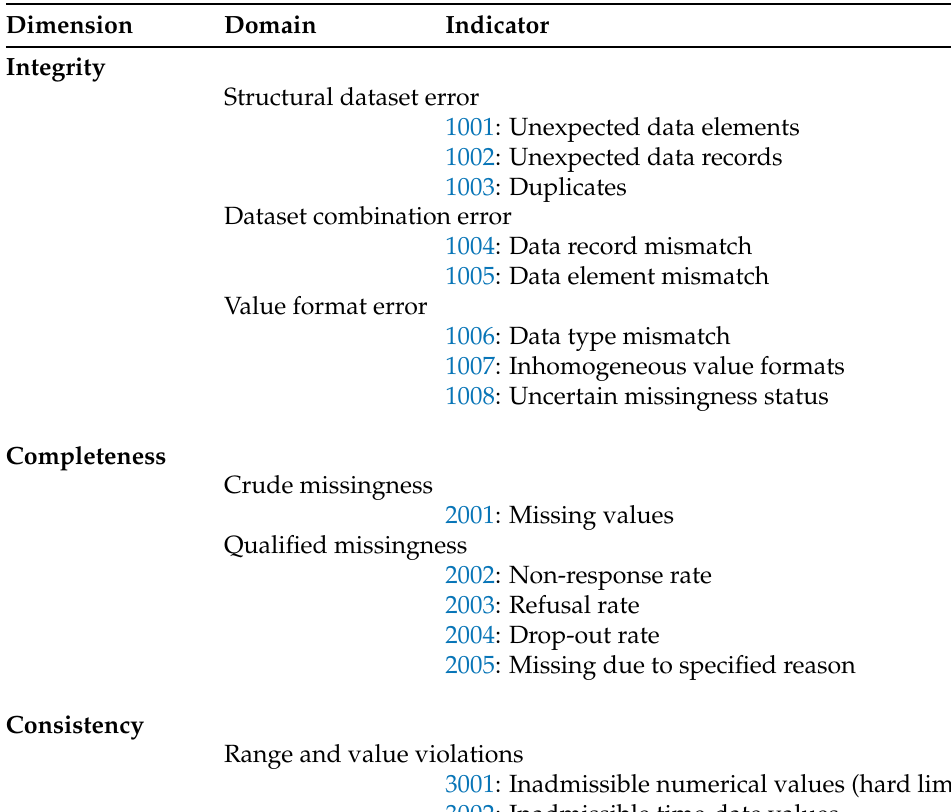
Table 1. Reference framework for harmonized data quality assessments [6,29] used to compare the selected R